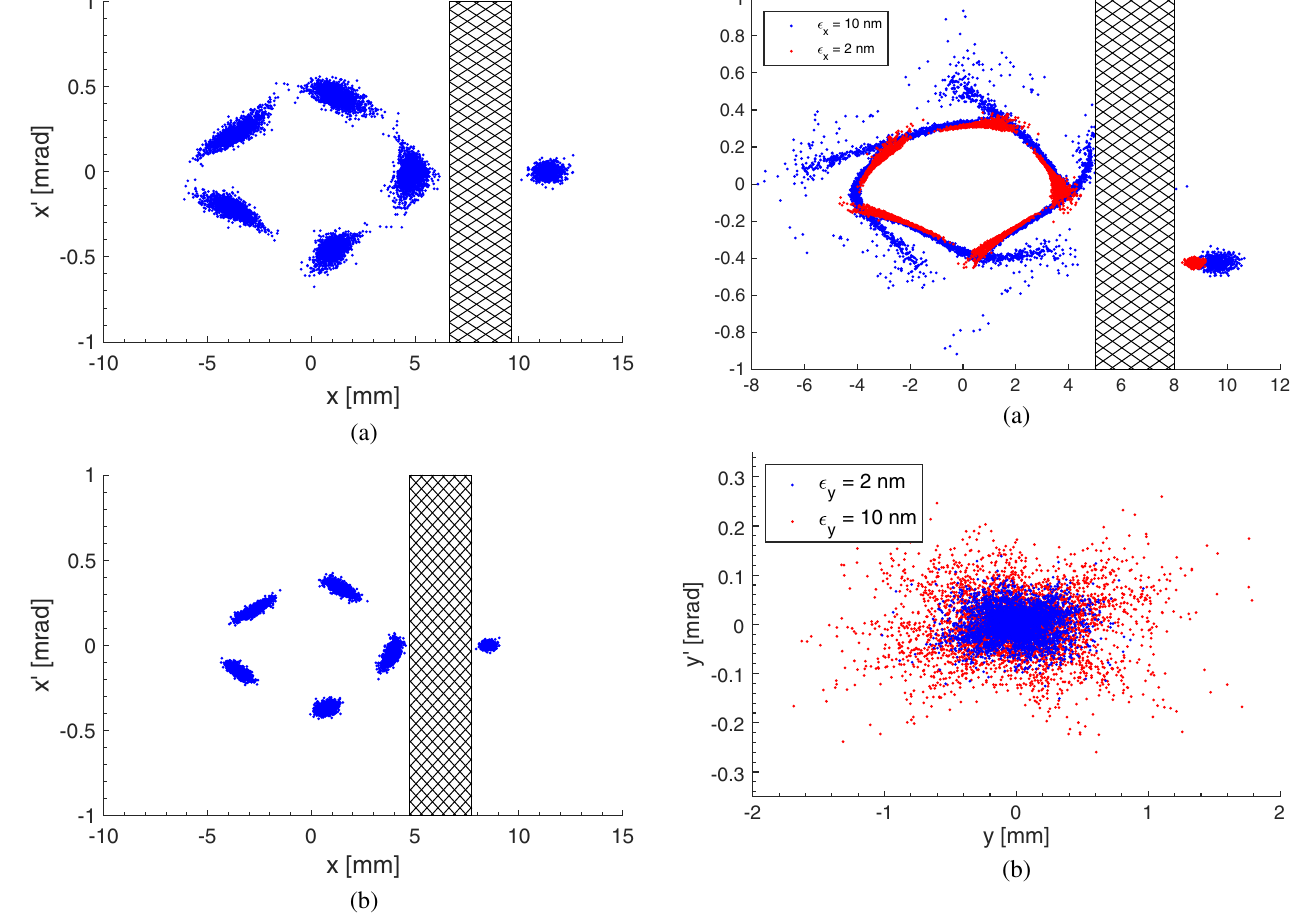
FIG. 2. Example of horizontal kicker bump injection into the SLS 2.0 storage ring. The first 10 turns in the machine is included. (a) ϵ x ¼ 10 nm rad without emittance exchange. (b) ϵ x ¼ 2 nm rad with emittance exchange. The required aper- ture is significantly decreased because the injected beam can be brought closer to the stored beam. a pulsed sextupole kicker injection example is plotted in Fig. 3. The smear of the injected beam is significantly decreased when emittances are exchanged. The feed-down quadrupole acts on the injected beam also in the vertical plane. The associated vertical emittance growth is not critical since the assumed equilibrium emittance of the booster is rather low in this simulation. For a multipole kicker injection with a large emittance booster, a partial emittance exchange may be applied to properly distribute the equilibrium emittance between the horizontal and vertical planes, maximizing the injection efficiency. The injection beam Twiss parameters can be matched taking into account the feed-down quadrupole of the multipole kicker if the injection beam line has the required capabil- ities. However, the injection beam size at the septum tends to be larger to compensate for a rather strong feed-down quadrupole.